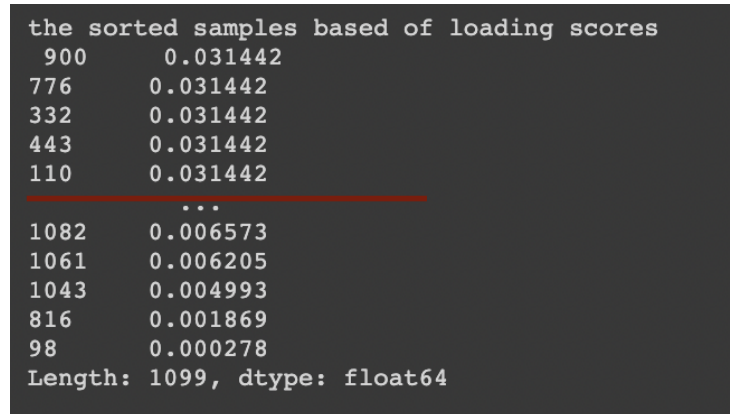
Figure 19. Threshold cutoff limit of the cancer patients dataset.